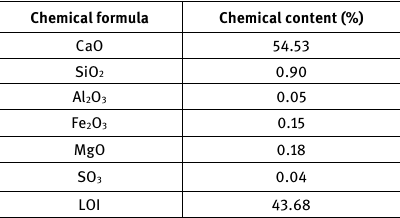
Table 3: The chemical composition of the